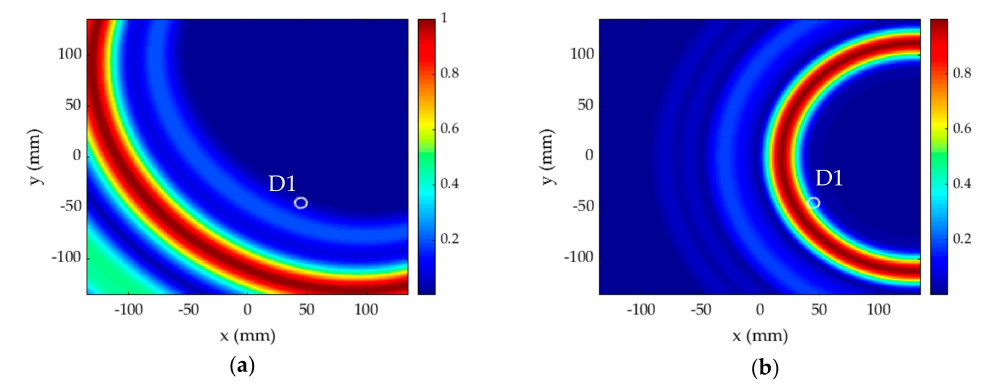
Figure 9. Possibilities of damage existence in single damage scenario for sensing path: ( a ) A2A8; ( b )